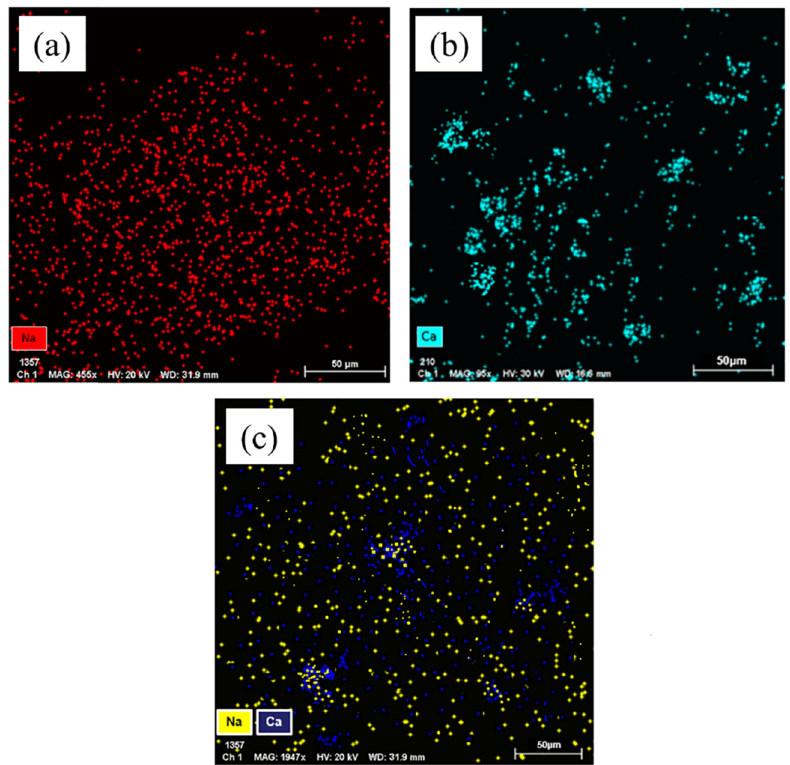
Figure 9: Na/Ca element mapping analysis of char residue of gasi fi cation: ( a ) residues of char with 5% Na 2 CO 3 addition, ( b ) residues of char with 5% CaCO 3 addition, and ( c ) residues of char with 2.5% Na 2 CO 3 and 2.5% CaCO 3 addition.